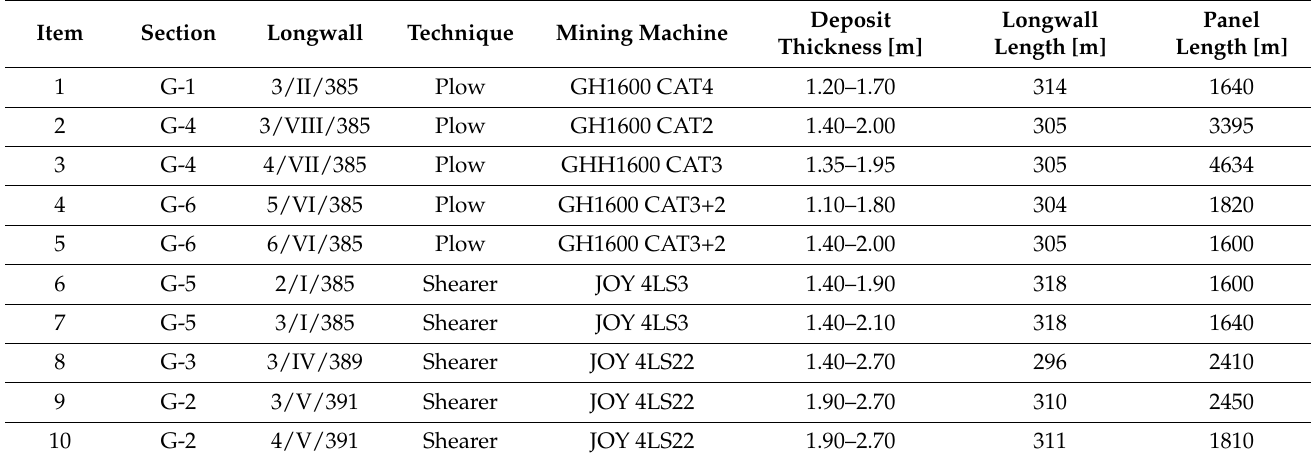
Table 1. List of parameters of the analysed longwalls in the LW Bogdanka mine.